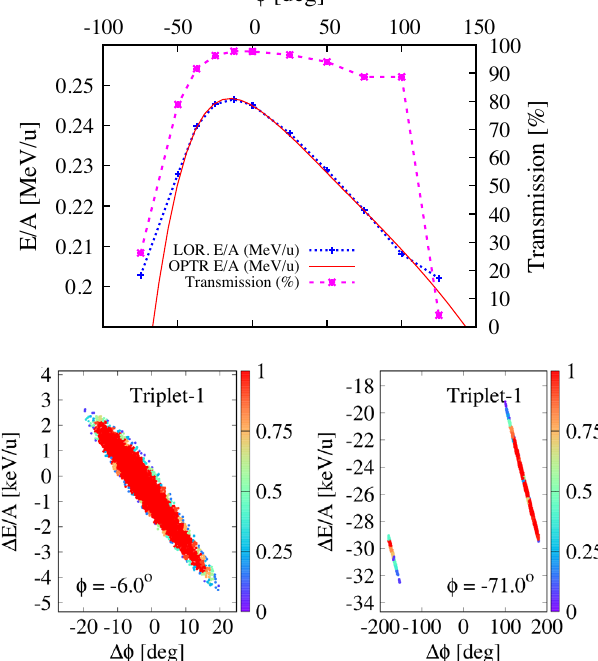
FIG. 7. Top: LORASR (blue) and TRANSOPTR (red) computed ISAC-DTL Tank-1 E=A vs ϕ response and associated LORASR particle transmission (pink), which sharply drops at phases far from maximum acceleration. The near optimum distribution ( − 6 °, bottom left) becomes severely broadened in time as the phase is detuned ( − 71 °, bottom right), causing particle losses into adjacent buckets which also shifts the average